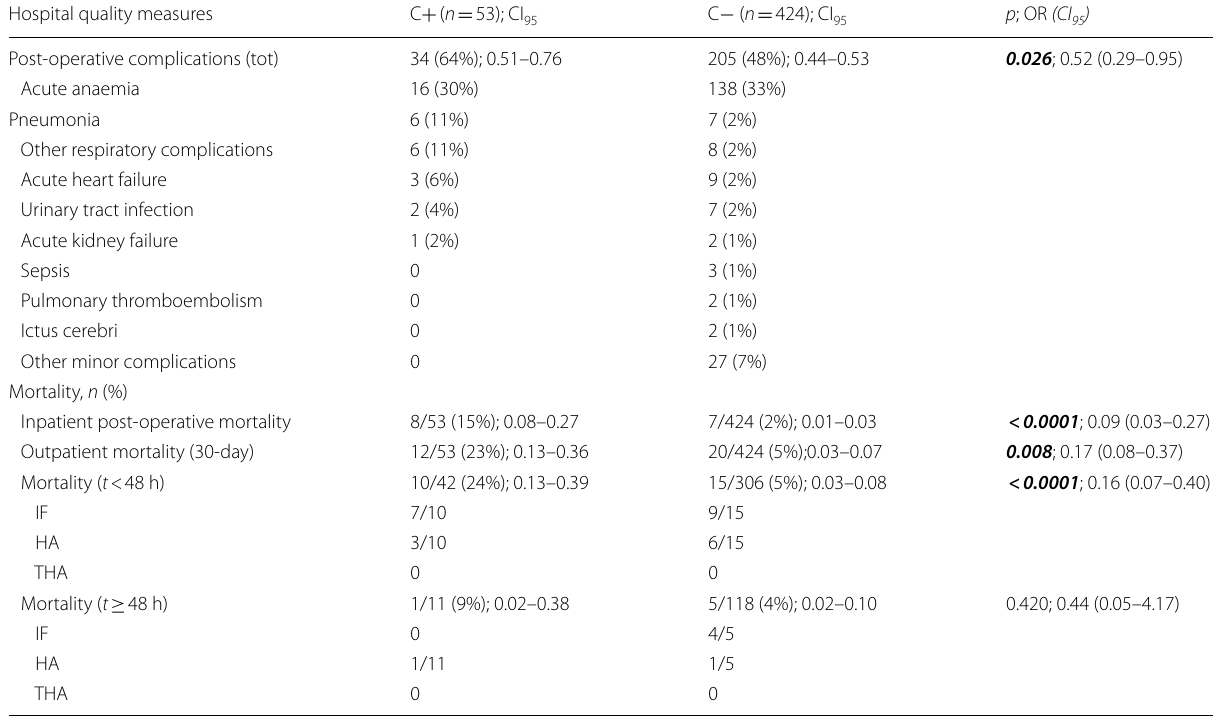
Statistically significant differences ( p < 0.05) are expressed as bold italic data t < or 48 h: treatment time from admission. OR: odds ratio. C ≥ Table 5 Internal fixation versus prosthetic implant for C